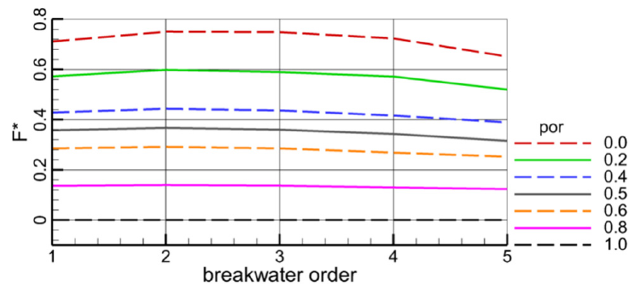
Figure 10. The maximum forces on the breakwaters with the different porosities.